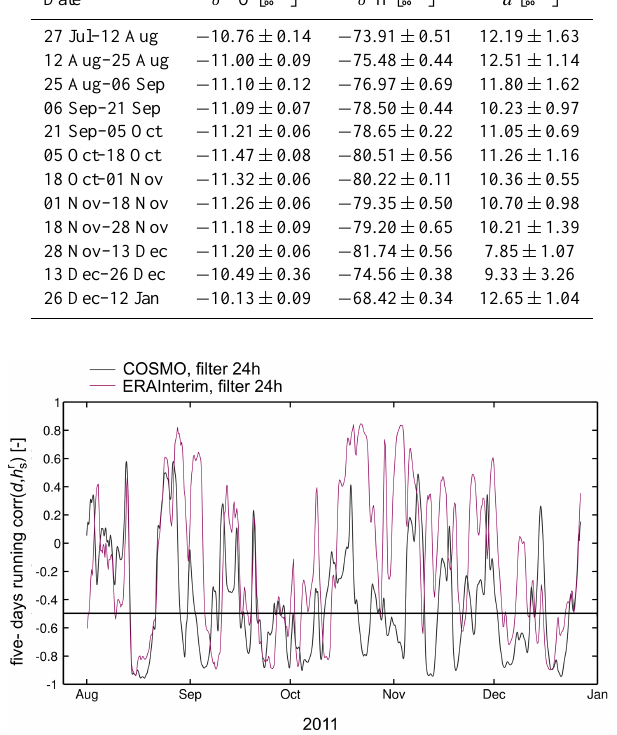
Fig. A1. Comparison of the 5-day moving window correlation be- tween 24h filtered d and diagnosed source h r s with COSMO (grey) and with ERA-Interim (violet). The horizontal black line shows the corr (d,h r s ) = − 0 . 5 line used as a threshold for the HRA event defi- nition in Sect. 5.3.